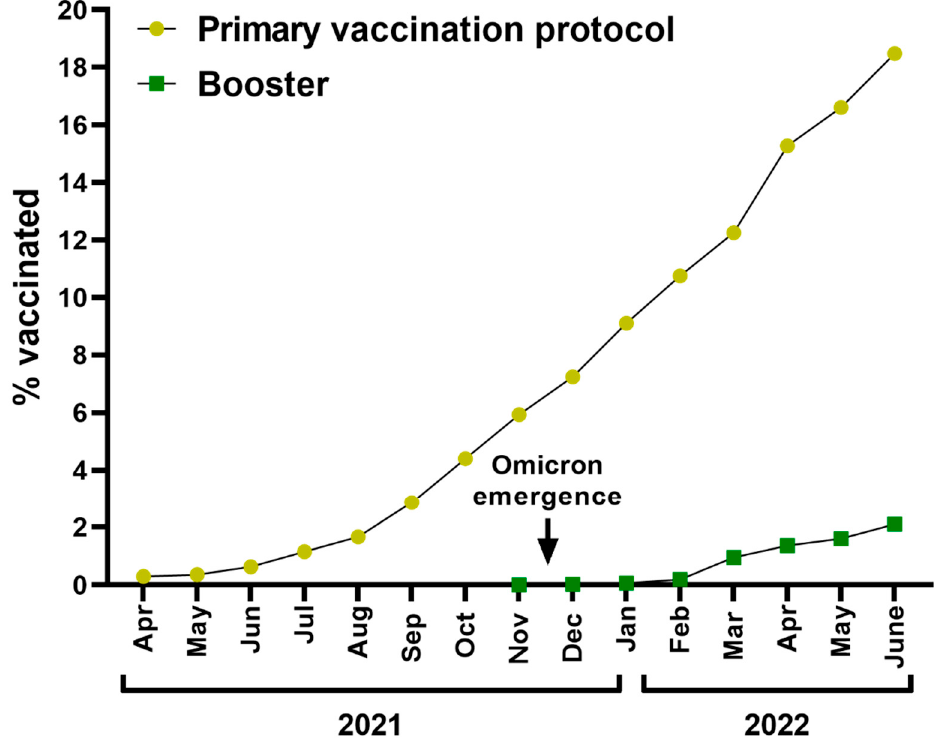
Figure 1. The percentage of the African population between April 2021 and June 2022 who completed the primary COVID-19 vaccination regime and were vaccinated with the booster dose (based on [8]).